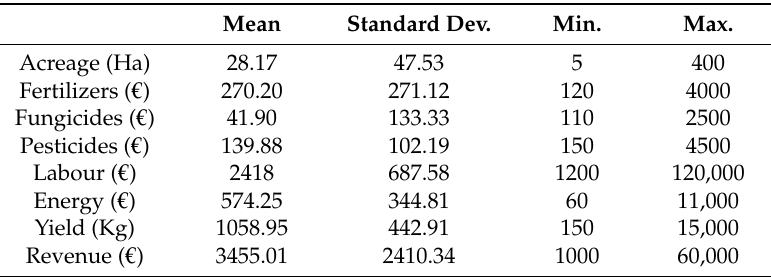
Table 1. Descriptive statistics of inputs and outputs.